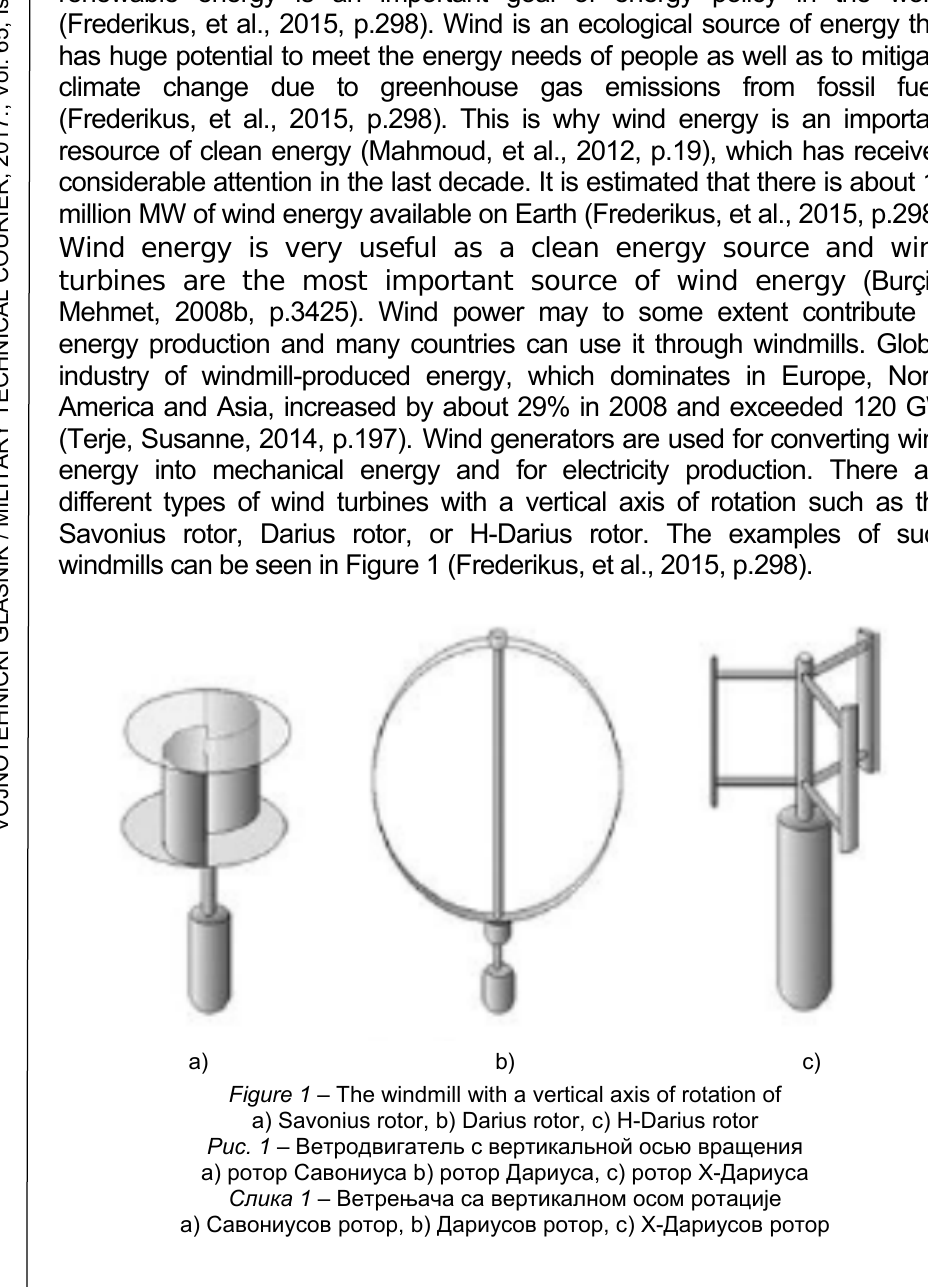
Figure 1 – The windmill with a vertical axis of rotation